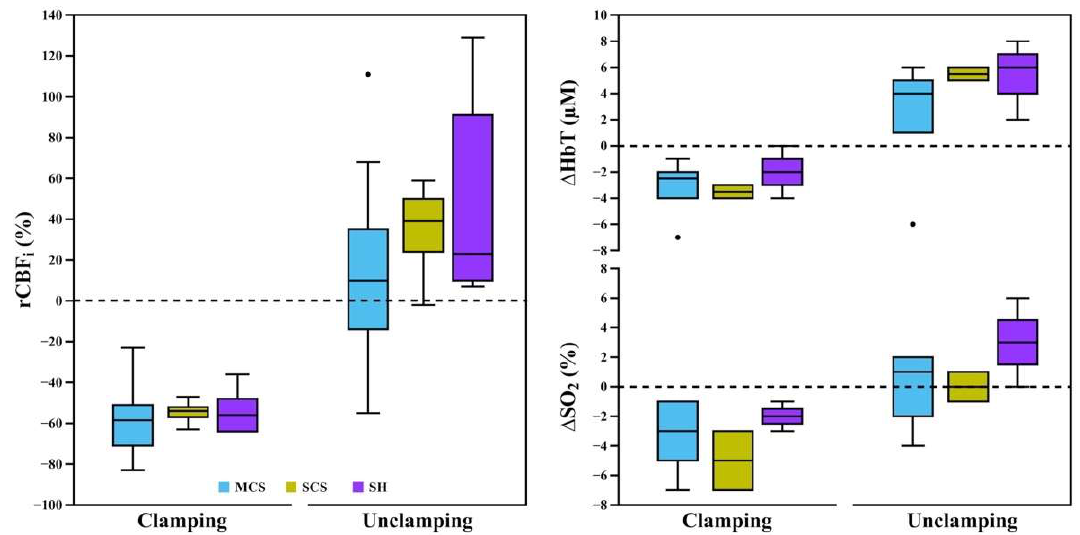
Figure 3. A quantified summary of short-term transient changes in clamping and unclamping in each group. rCBF i , ∆HbT, and ∆SO 2 were quantified with respect to the short baseline. All data are represented in a whisker plot. Black-filled circles represent outliers. rCBF i , relative cerebral blood flow index; ∆HbT, changes in total hemoglobin concentration; ∆SO 2 , changes in oxygen saturation; MCS, normal-to-mild contralateral stenosis group (<50%); SCS, moderate-to-substantial contralateral stenosis group (≥50%); SH, shunt utilization group.